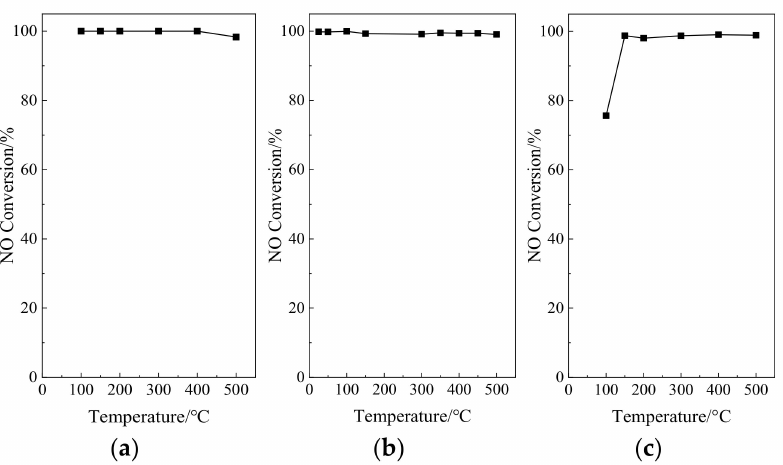
Figure 8. NO conversion vs. temperature: ( a ) Fe 0.8 Cu 0.2 /RHA; ( b ) Fe 0.67 Cu 0.33 /RHA; ( c ) Fe 0.5 Cu 0.5